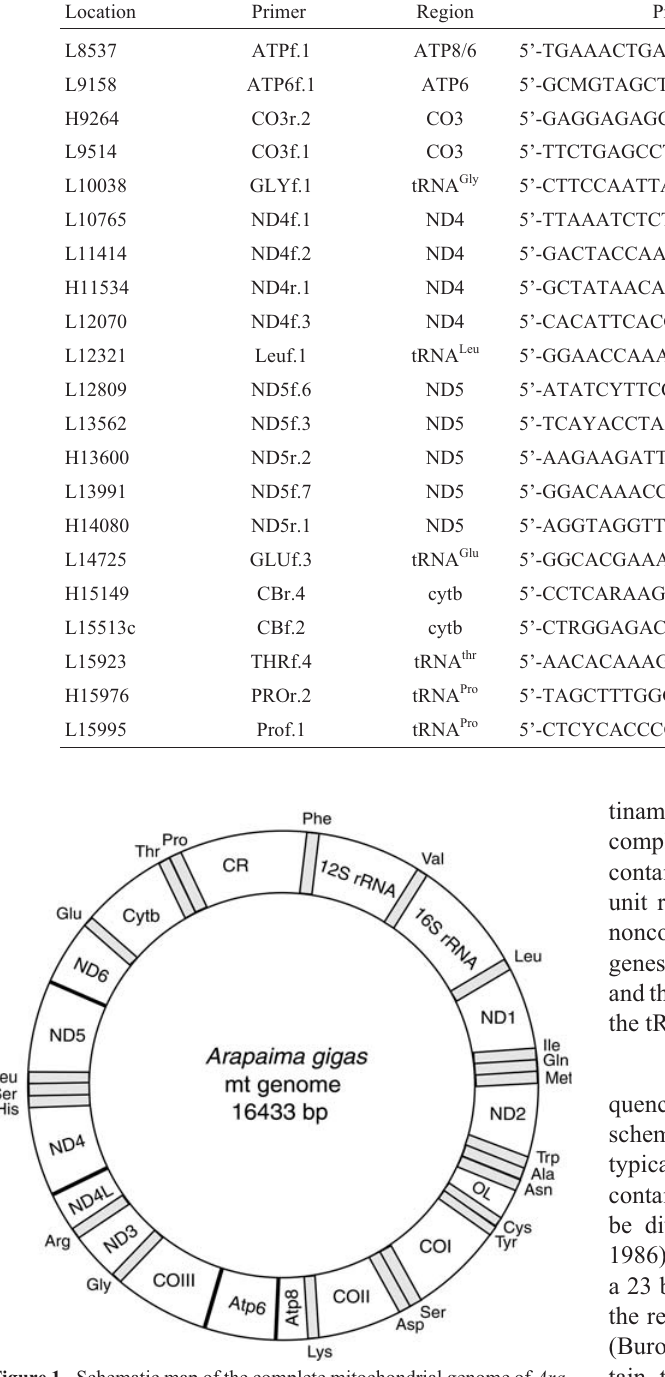
Figure 1 - Schematic map of the complete mitochondrial genome of Ara- paima gigas